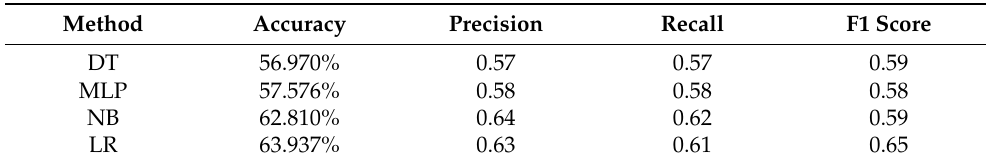
Table 4. Comparison of experimental results using typical classification methods for the two classes of Arabic comments.